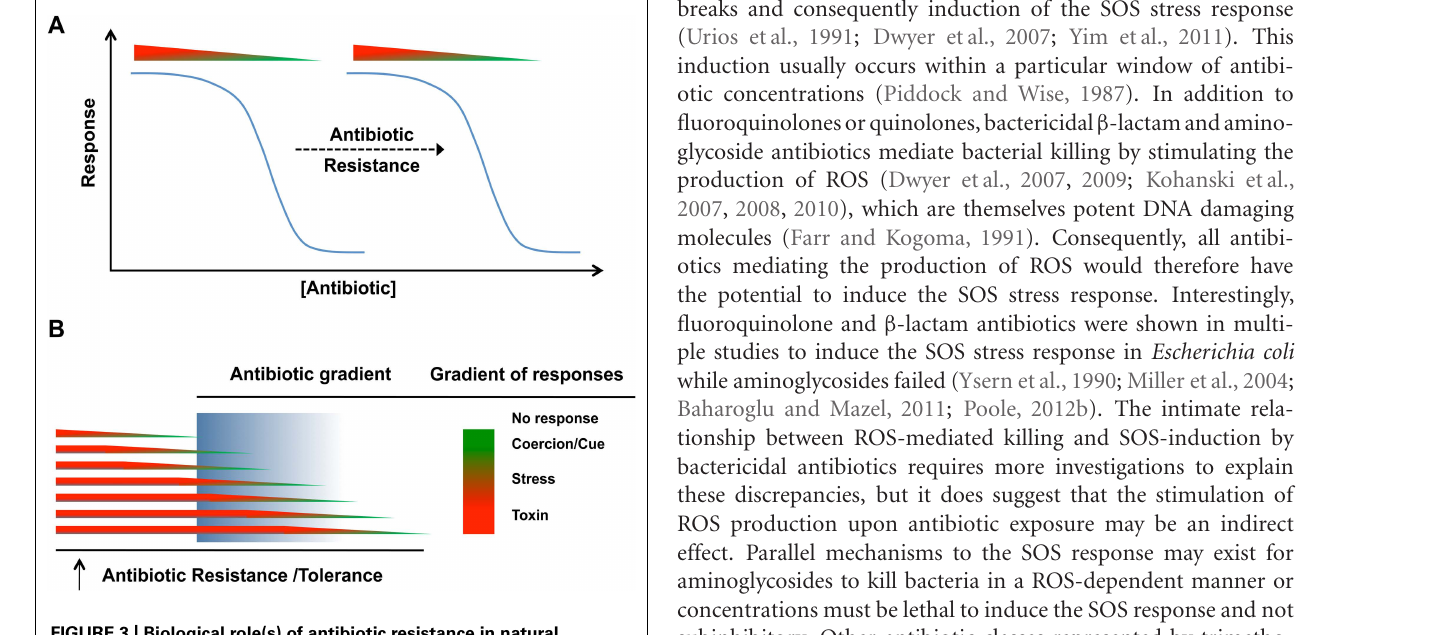
FIGURE 3 | Biological role(s) of antibiotic resistance in natural communities. (A) The response of bacterial cells to antibiotic whether it is bactericidal/bacteriostatic or subinhibitory, the biological response (as a cue or coercion) will be shifted by antibiotic resistance. (B) In natural environments, differences in physiological states can impact the expression of antibiotic resistance or tolerance mechanisms. Antibiotic concentrations in these environments may also be distributed as gradients, meaning that the population will not necessarily respond